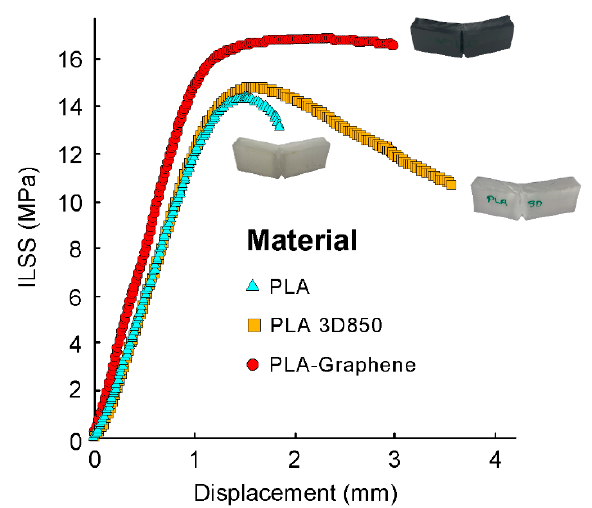
Figure 6. Average ILSS-displacement curves under different printing conditions. Cross-sectional optical micrographs showing the details of the failure modes for the different configurations.